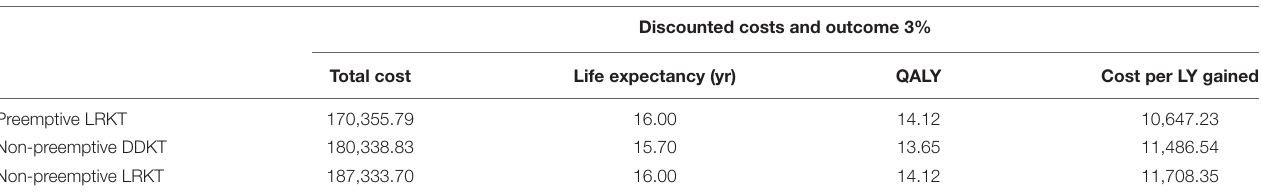
FIGURE 2 | Tornado diagram of preemptive LRKT versus non-preemptive DDKT. HD, hemodialysis; KT, kidney transplantation; NP-DDKT, non-preemptive deceased-donor kidney transplantation; P-LRKT, preemptive living-related kidney transplantation; RR, relative risk. TABLE 3 | Costs, outcomes, and cost per life year gained of base-case analysis.